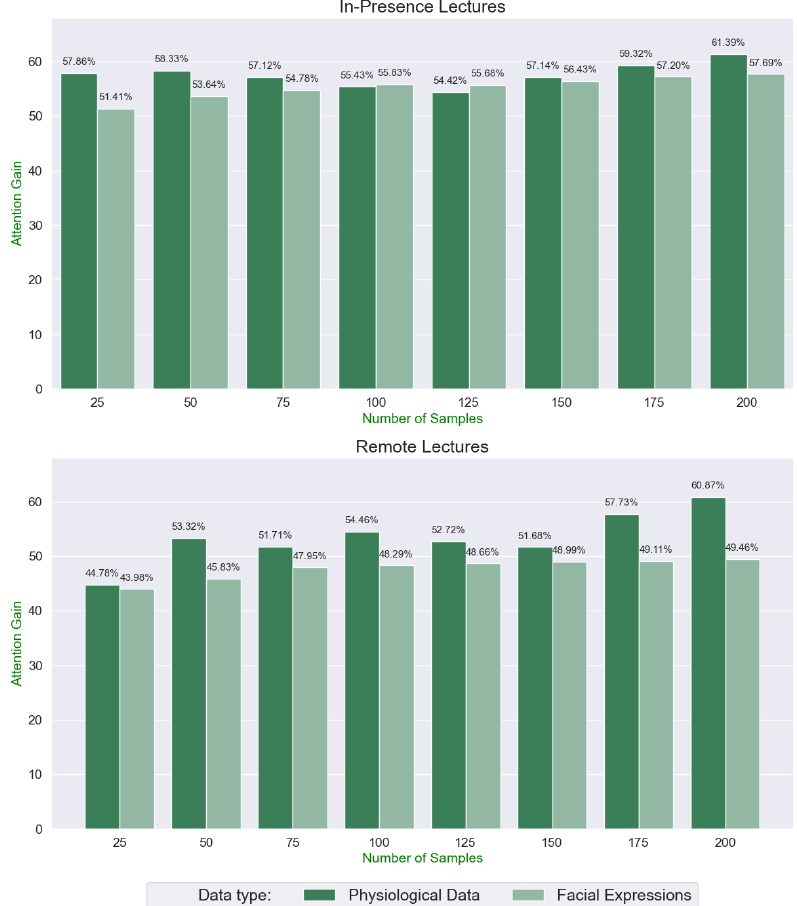
Figure 3. Comparison of the AG s obtained from the AA p and AA fe during the in-presence and remote lectures with different windows